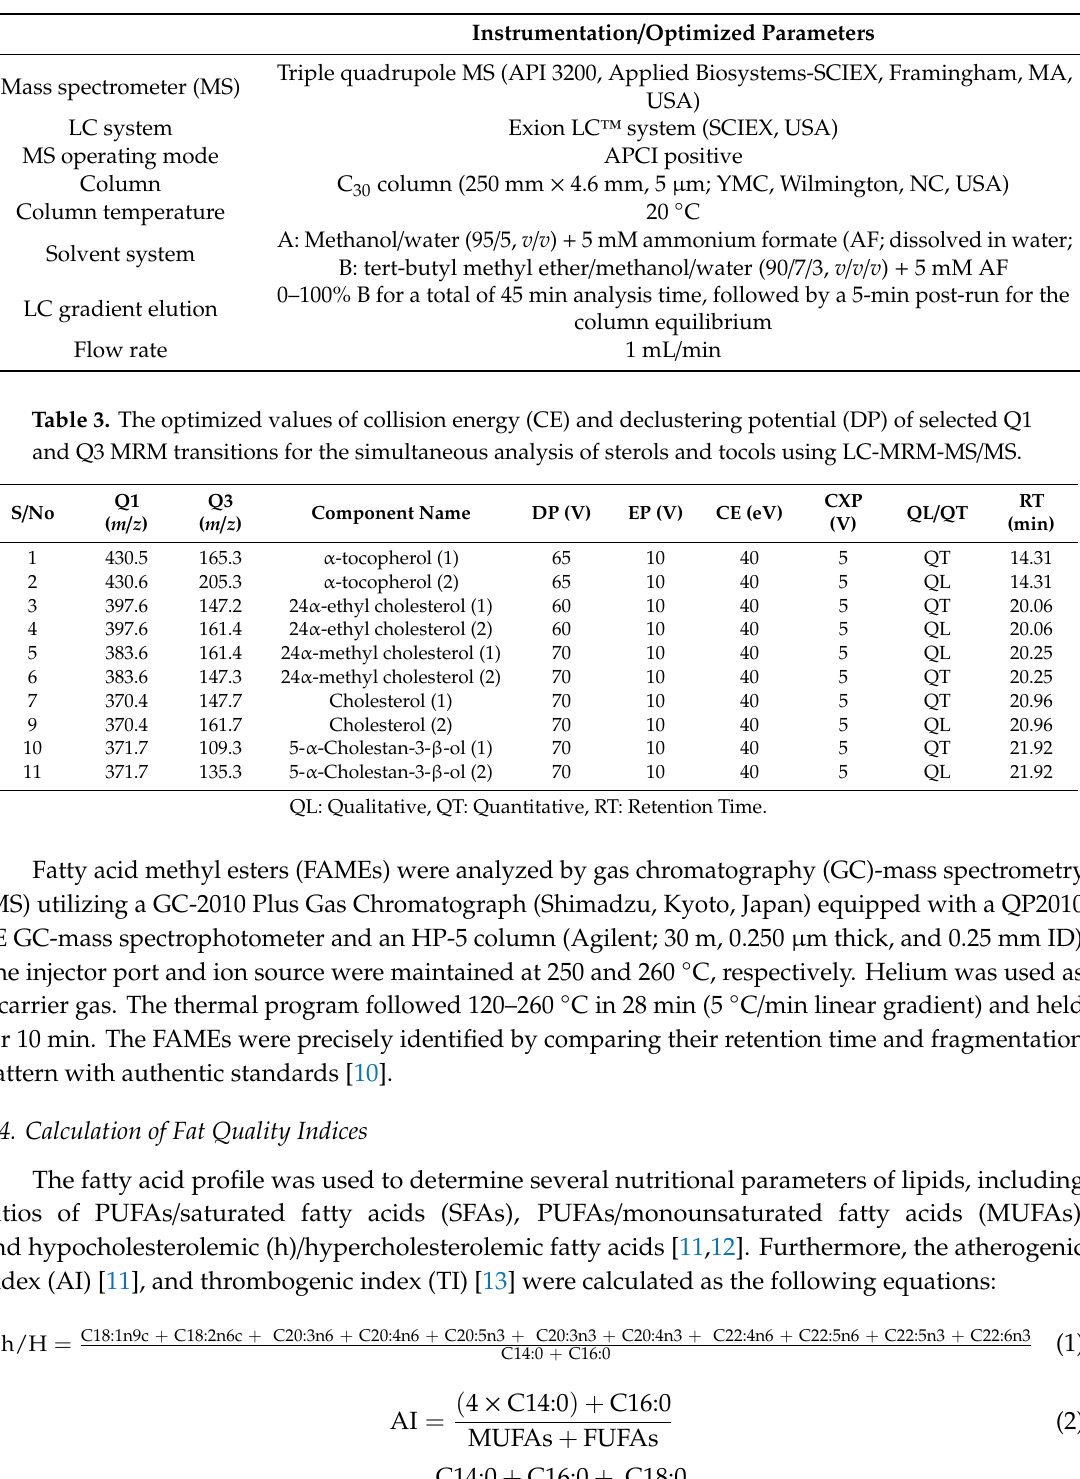
Table 2. The optimized instrumental parameters for the simultaneous analysis of sterols and tocols using liquid chromatography-multiple reaction monitoring-mass spectrometry (LC-MRM-MS / MS).